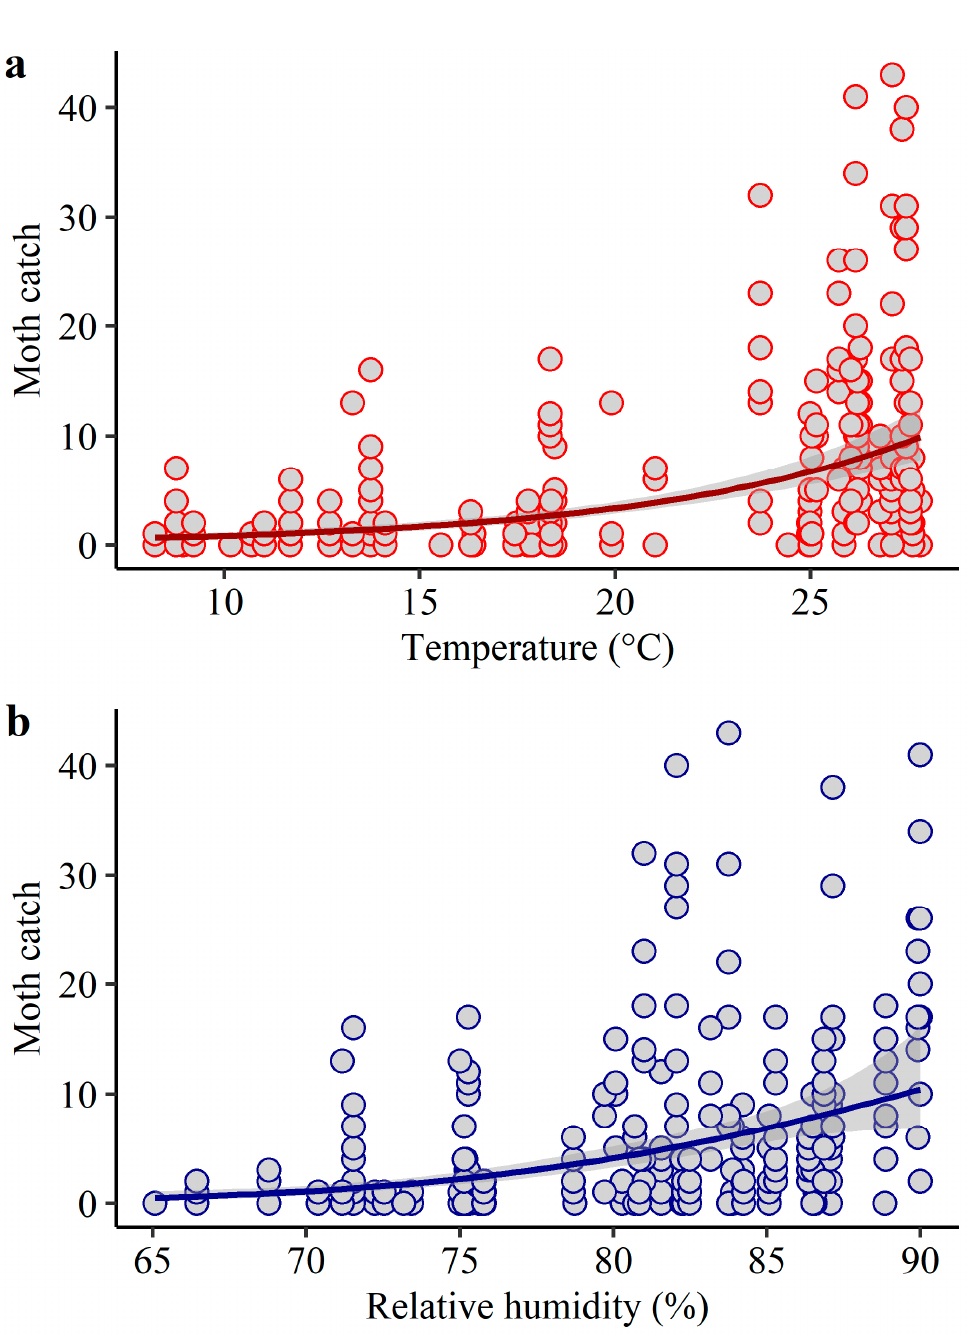
Figure 5. Expected H. zea moth catch as a function of ( a ) temperature, and ( b ) relative humidity in Jackson County, Florida. Solid lines indicate the fitted model (GLM with a negative binomial error distribution) and grey bands indicate the confidence intervals. Circles represent the total number of insects collected from commercial fields fortnightly, for two years, using sex-pheromone trapping (n = 339).